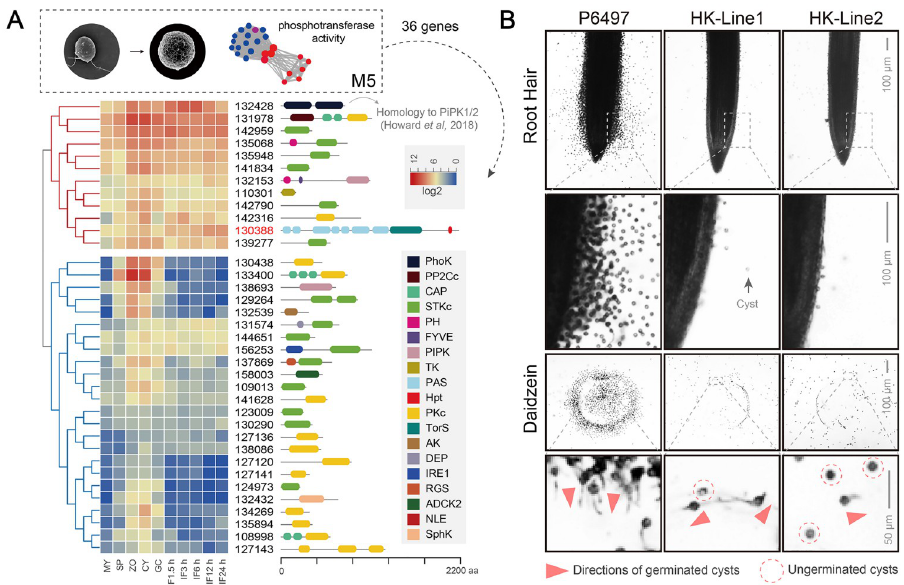
Fig 4. A histidine kinase (HK) with phosphotransferase activity necessary for zoospore chemotaxis in P . sojae . (A) On the left shows that hierarchical clustering of the genes with phosphotransferase activity from fifth module in Fig 2. And on the right show the corresponding domain structures. (B) Analyses of zoospore chemotaxis to root hairs and agar blocks with daidzein. Root tips or agar blocks contains daidzein were placed in glass slides containing equal amounts of zoospore suspensions from the wild-type (P6497) and HK-knockout mutants (HK-Line1 and HK-Line2). Photos were taken after 5 min in root hairs and 20 min in agar blocks, while most of the zoospores got encysted. The directions of germinated cysts were indicated with red triangles. The Germinated cysts were marked with dotted circles. All experiments were repeated three times with similar results.